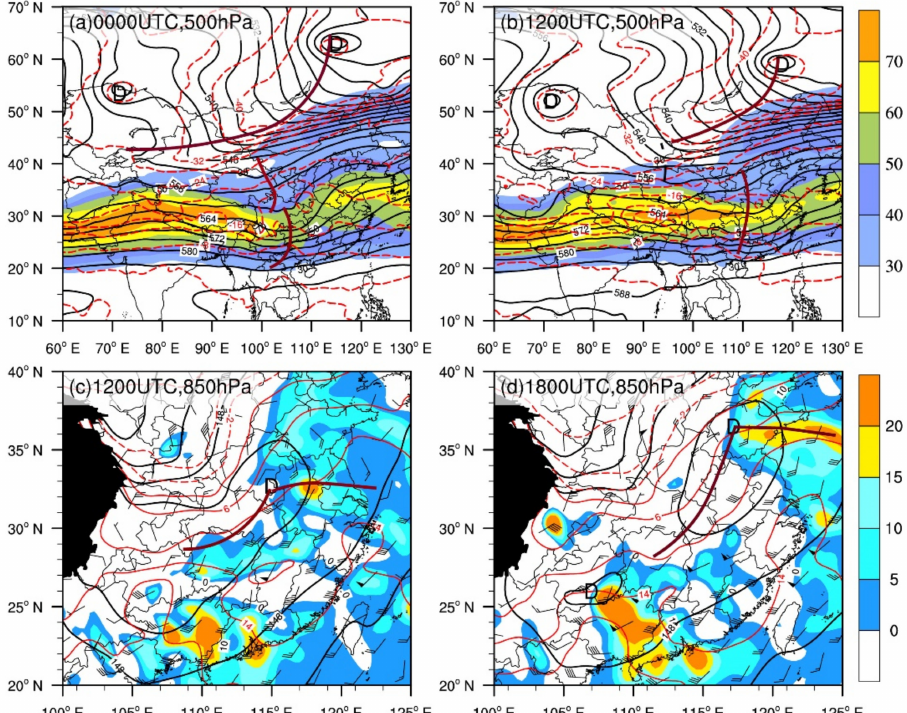
Figure 3. NCEP GFS analysis at ( a ) 0000 UTC, ( b , c ) 1200 UTC, and ( d ) 1800 UTC on 12 February 2016. ( a , b ) Geopotential height (black solid lines; unit: dagpm), temperature (red dashed lines; unit: ◦ C) at 500 hPa, and 200 hPa wind speeds ≥ 30 m · s − 1 are shown shaded. The brown thick lines denote troughs. ( c , d ) Geopotential height (black solid lines; unit: dagpm), temperature (red lines; unit: ◦ C), wind barbs (full barb = 4 m · s − 1 , pennant = 20 m · s − 1 ), and temperature advection >0 (shaded; unit: 10 − 5 K · s − 1 ) at 850 hPa. The brown thick lines denote shear